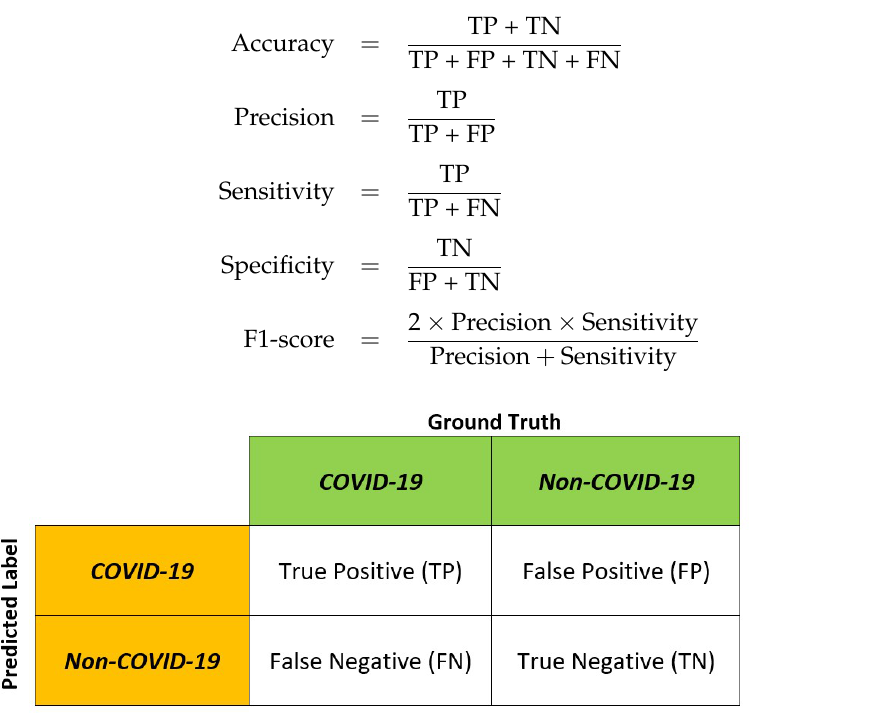
Figure 3. True Positive (TP), True Negative (TN), False Positive (FP) and False Negative